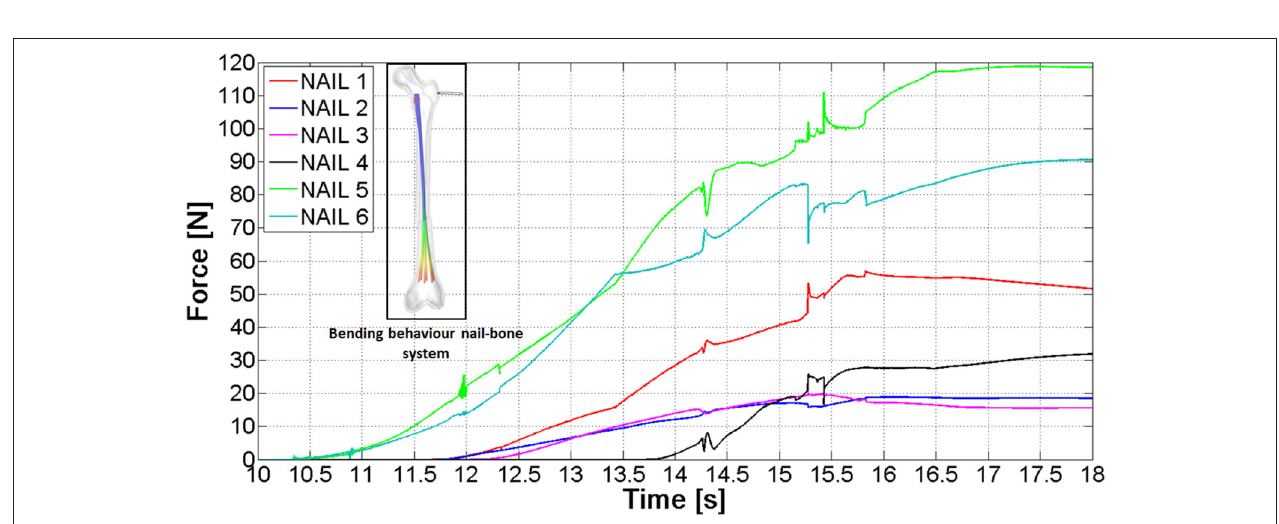
FIGURE 9 | Contact forces between the six nails and the distal fragment.